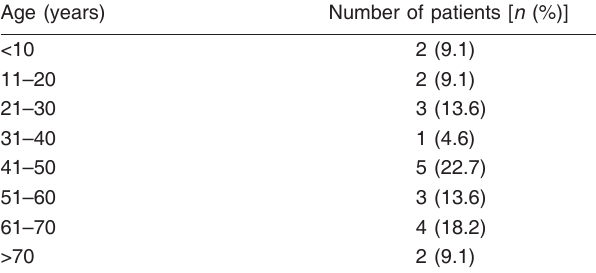
Table 2 Age of the patients at